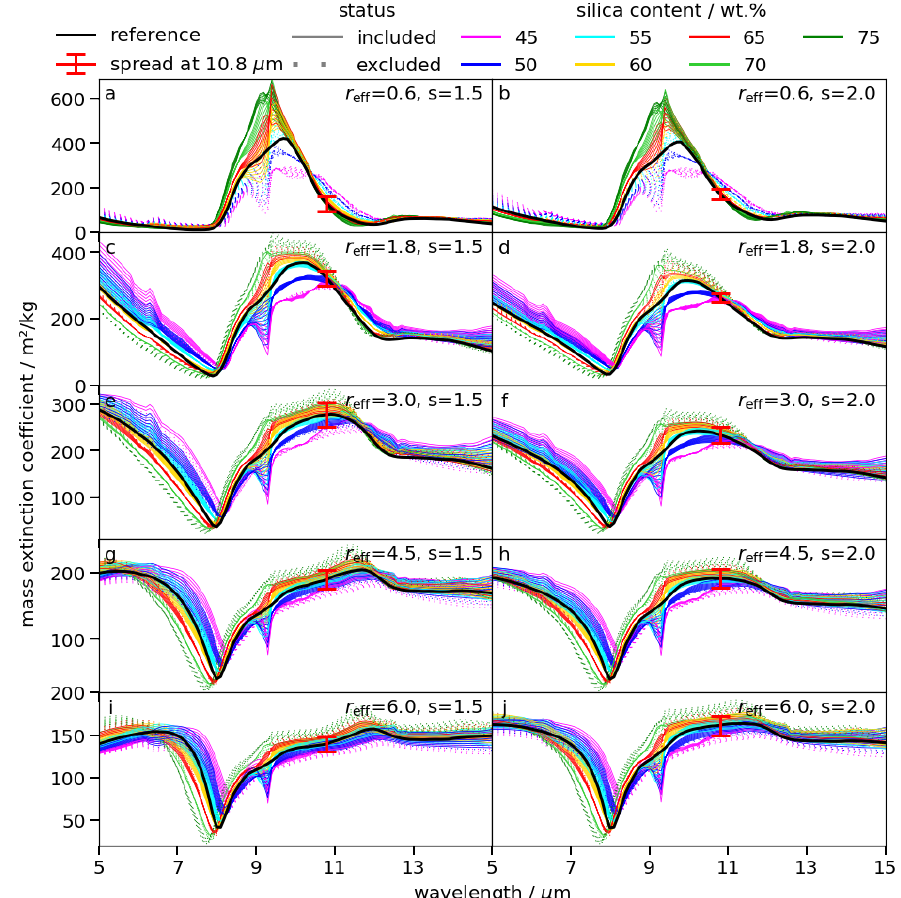
Figure 6. Mass extinction coefficient of the volcanic ash types derived by Piontek et al. [23] and (in black) for Eyjafjallajökull ash [75] as reference. The silica content x s is denoted by the color and the status (included or excluded with respect to the simulated dataset) by the linestyle. The mass extinction coefficient at 10.8µm of Eyjafjallajökull ash and the standard deviation of all mass extinction coefficients at 10.8µm are given by the red marker. The panels show subsets of different r eff and s